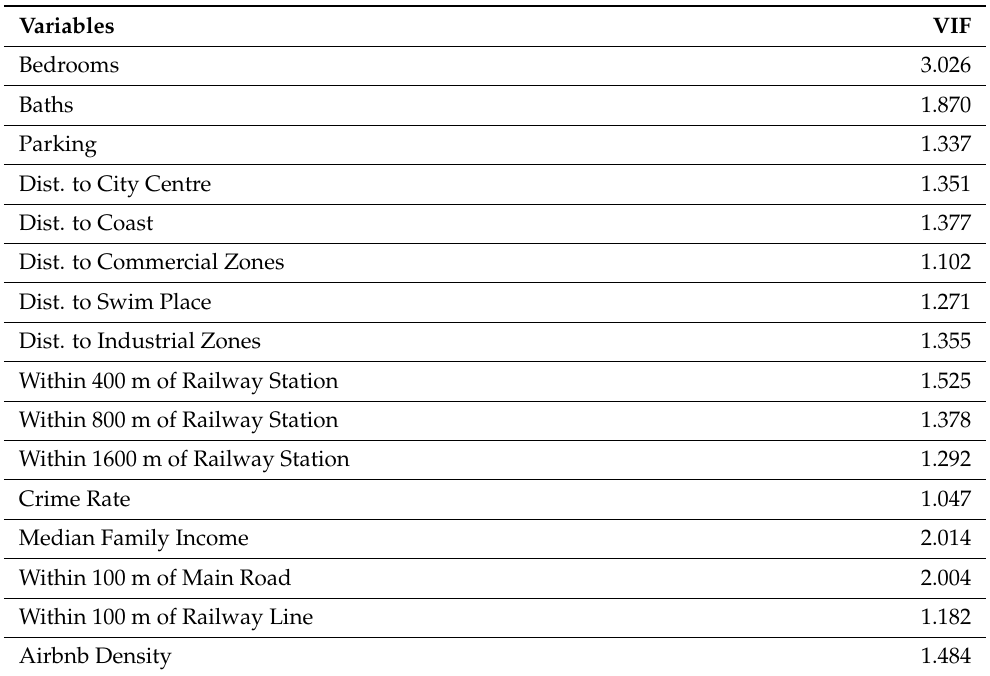
Table A2. Variance Inflation Test run on OLS